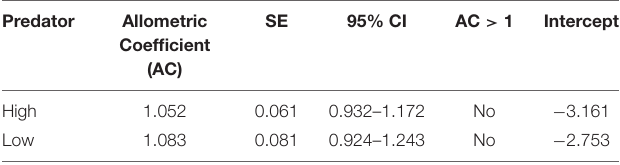
TABLE 2 | Allometric coefficients for Alfaro cultratus in high-predation and low-predation environments. Predator